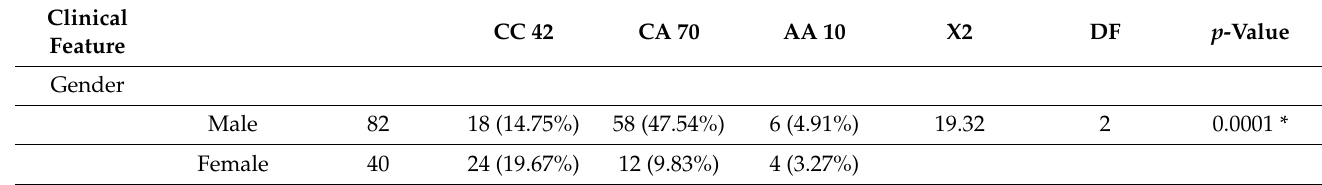
Table 7. Association of VEGF rs699947 C/A genotypes with T2D patients’